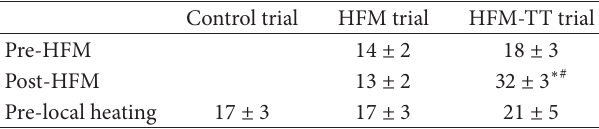
Table 3: Baseline %CVC max data. Baseline values for the three experimental trials. Pre-HFM was defined as the three-minute period just prior to either the thermoneutral or TT; post-HFM was defined as the three-minute period immediately preceding the end of either the thermoneutral or TT; pre-local heating was defined as the three-minute period just prior to beginning the local heating protocol. HFM: high fat meal; HFM-TT:high fat meal plusmild heat stress trial. ∗ 𝑃 < 0.05 versus same time point compared to HFM; # 𝑃 < 0.05 versus pre-HFM and pre-local heating within the same trial. Values are means ±